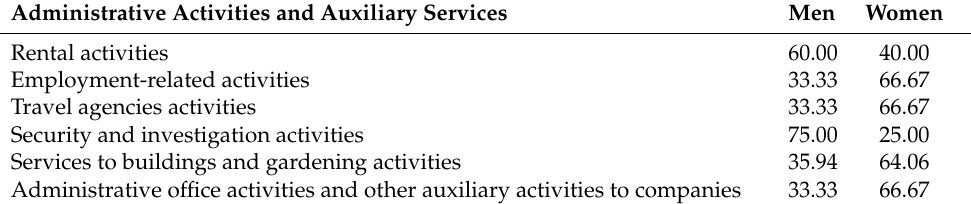
Table 7. Percentage distribution of employment by sectors in the activity branch “Administrative activities and auxiliary